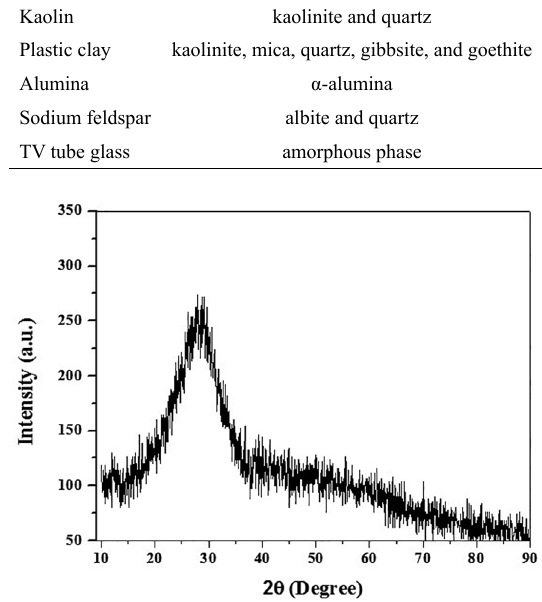
Figure 1. X-ray diffraction pattern of the TV tube glass